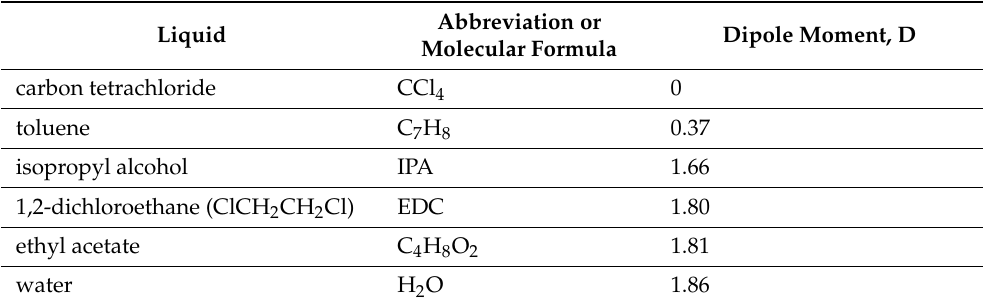
Table 1. Elemental composition, designation and polarity of the studied liquids molecules. Abbreviation or Liquid Molecular